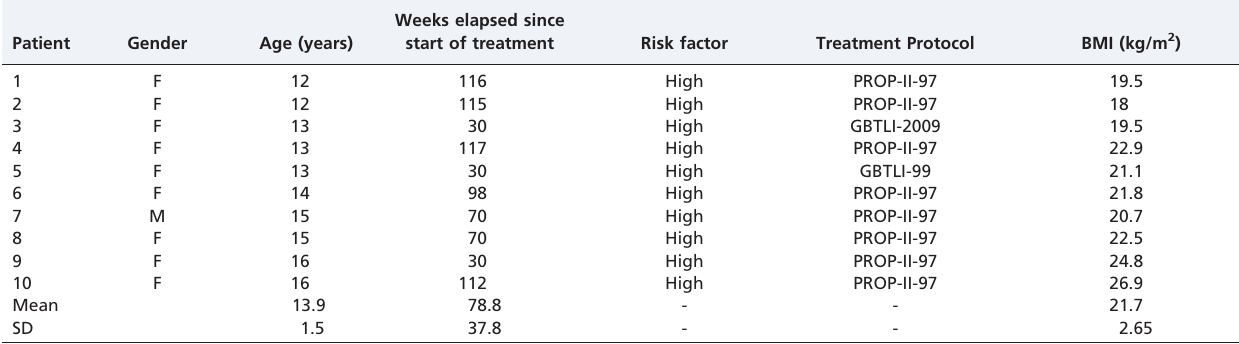
Table 1 - Physical characteristics and treatment protocols for the patients in the ALL